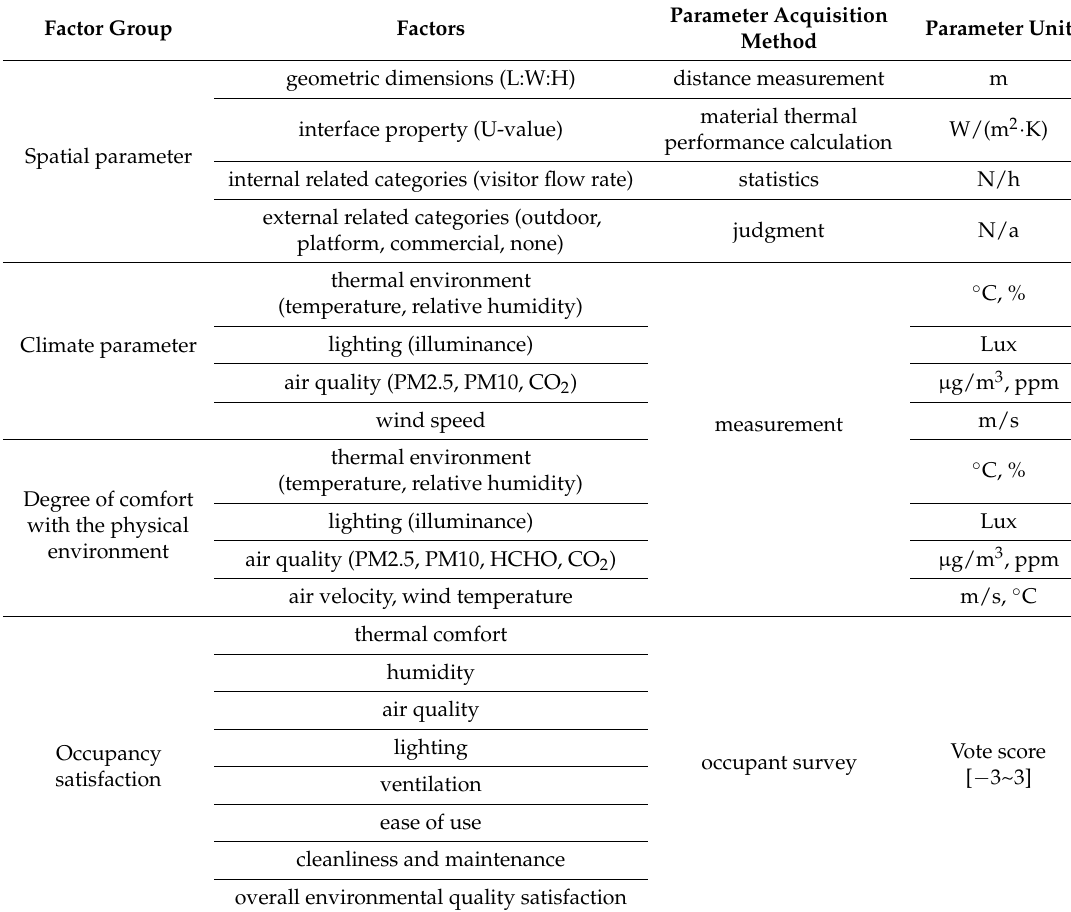
Table 1. Factor analysis of the passive adjustment effect of tubular